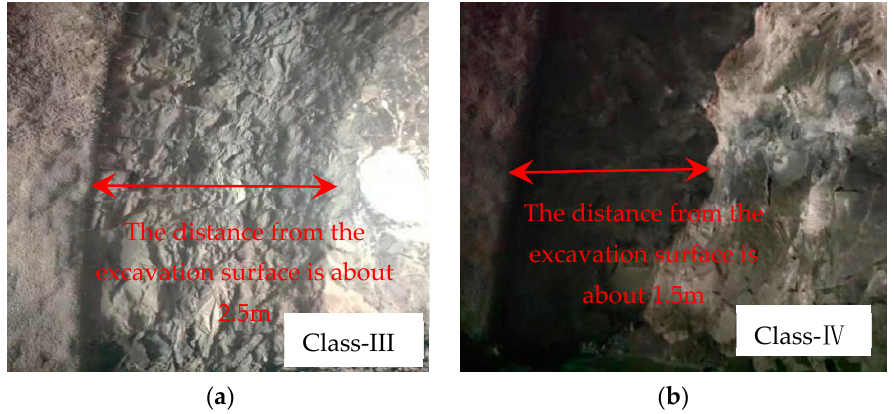
Figure 13. Site surrounding rock-support spacing map: ( a ) Class − III surrounding rock; ( b ) Class − IV surrounding rock.